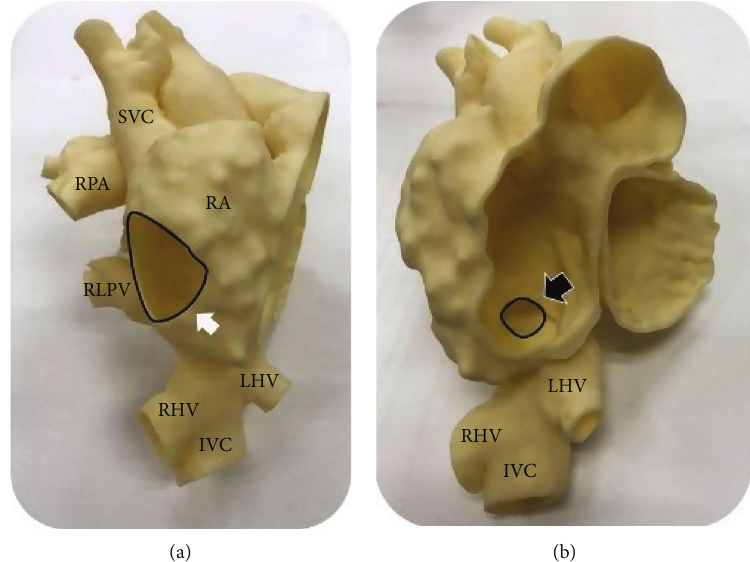
Figure 4: Anterior aspect of a 3-dimensional model from cardiac magnetic resonance imaging. (a) The superior vena cava- (SVC-) right atrium (RA) junction, right pulmonary artery (RPA), right lower pulmonary vein (RLPV), right hepatic vein (RHV), left hepatic vein (LHV), and inferior vena cava (IVC) can be observed. An opening was arti fi cially created (white arrow) to facilitate a simulated view into the lateral aspect of the RA. (b) A sinus venosus defect was identi fi ed at the IVC-RA junction (black arrow).